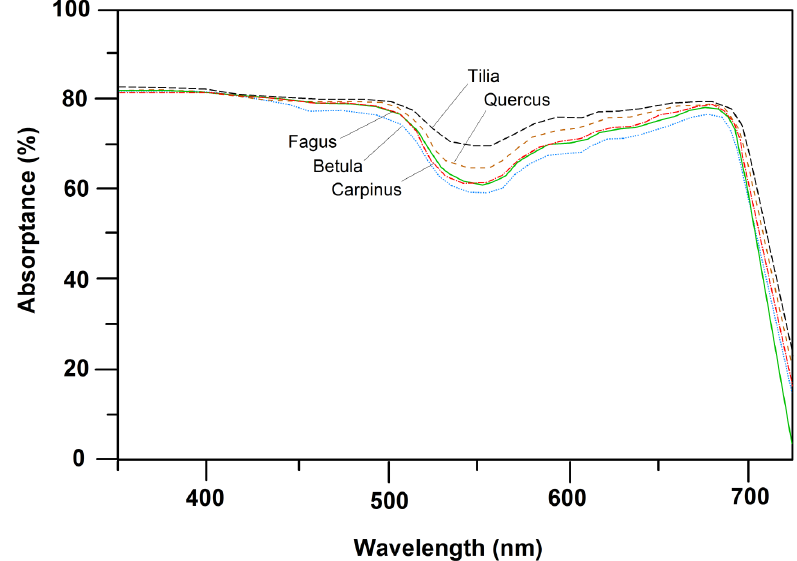
Figure 2. PAR-absorptance spectra of upper sun-canopy leaves of the five species with consideration of leaf specular properties. Depicted are mean curves of spectroradiometer measurements on each 10 leaves per species. For standard deviations of means see Figure S2 in the Supplement.